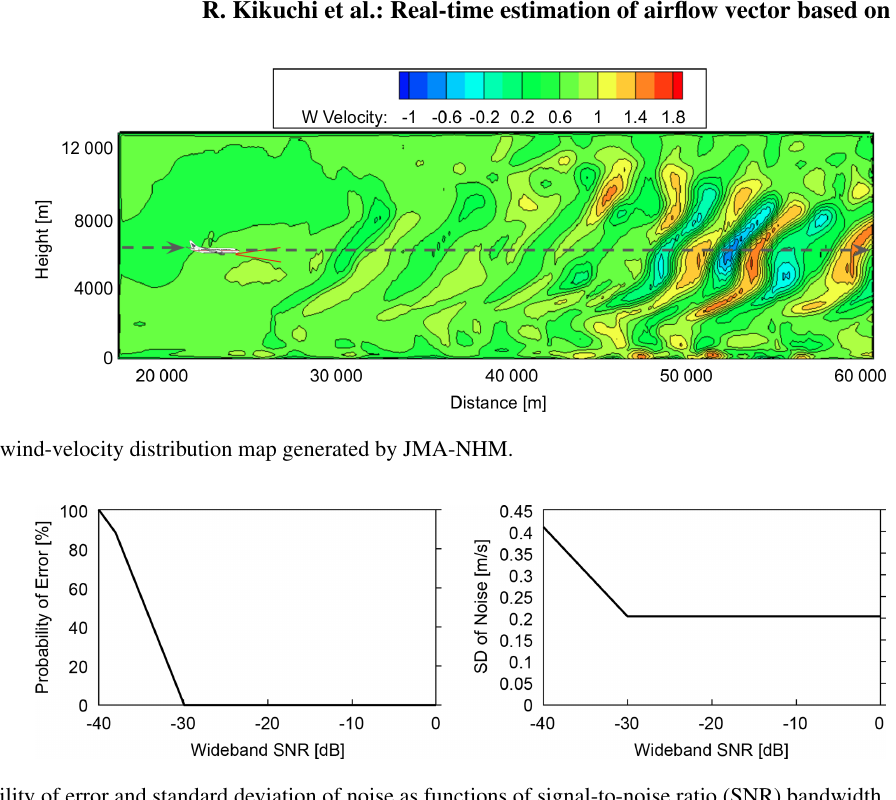
Figure 10. Probability of error and standard deviation of noise as functions of signal-to-noise ratio (SNR)